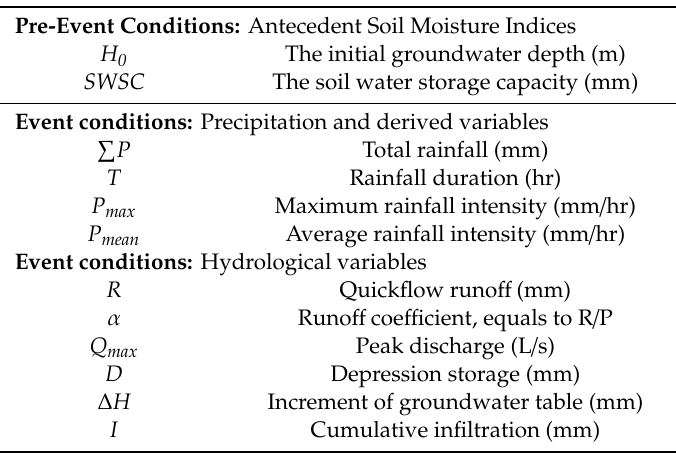
Table 2. Pre-event and event variables